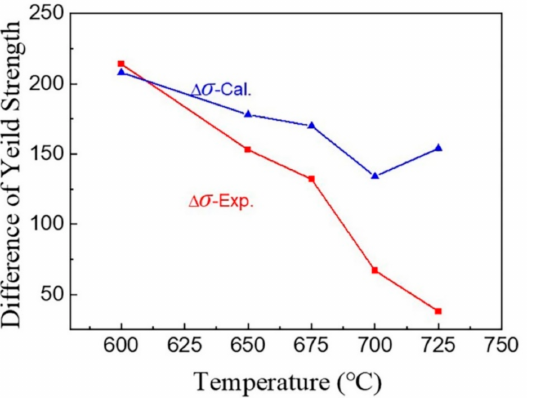
Figure 12. Calculated and experimental yield strength differences between HV and LV